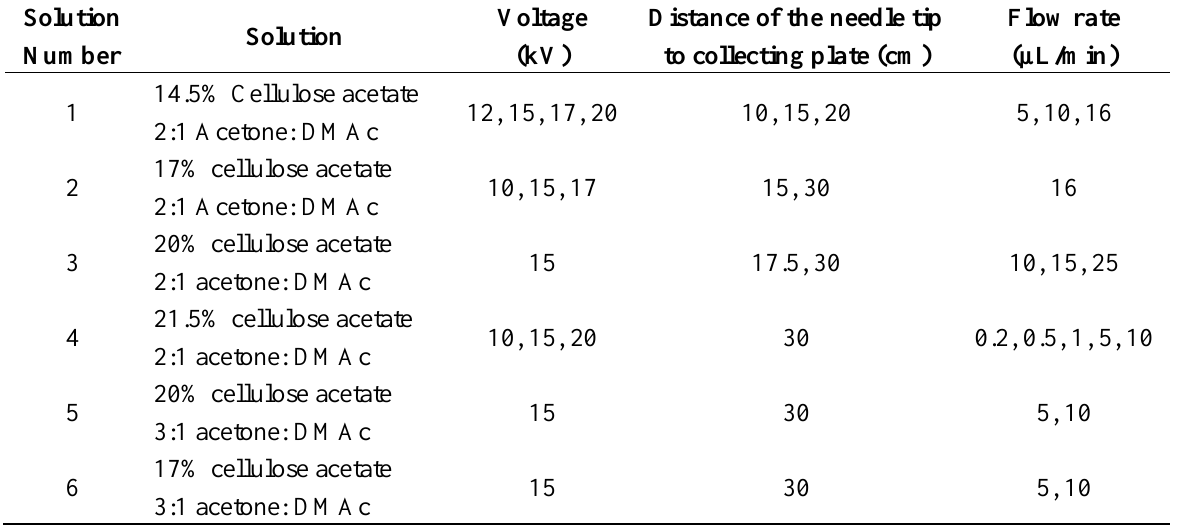
Table 1. Solutions and spinning parameters tested to investigate the production of defect free fibres.